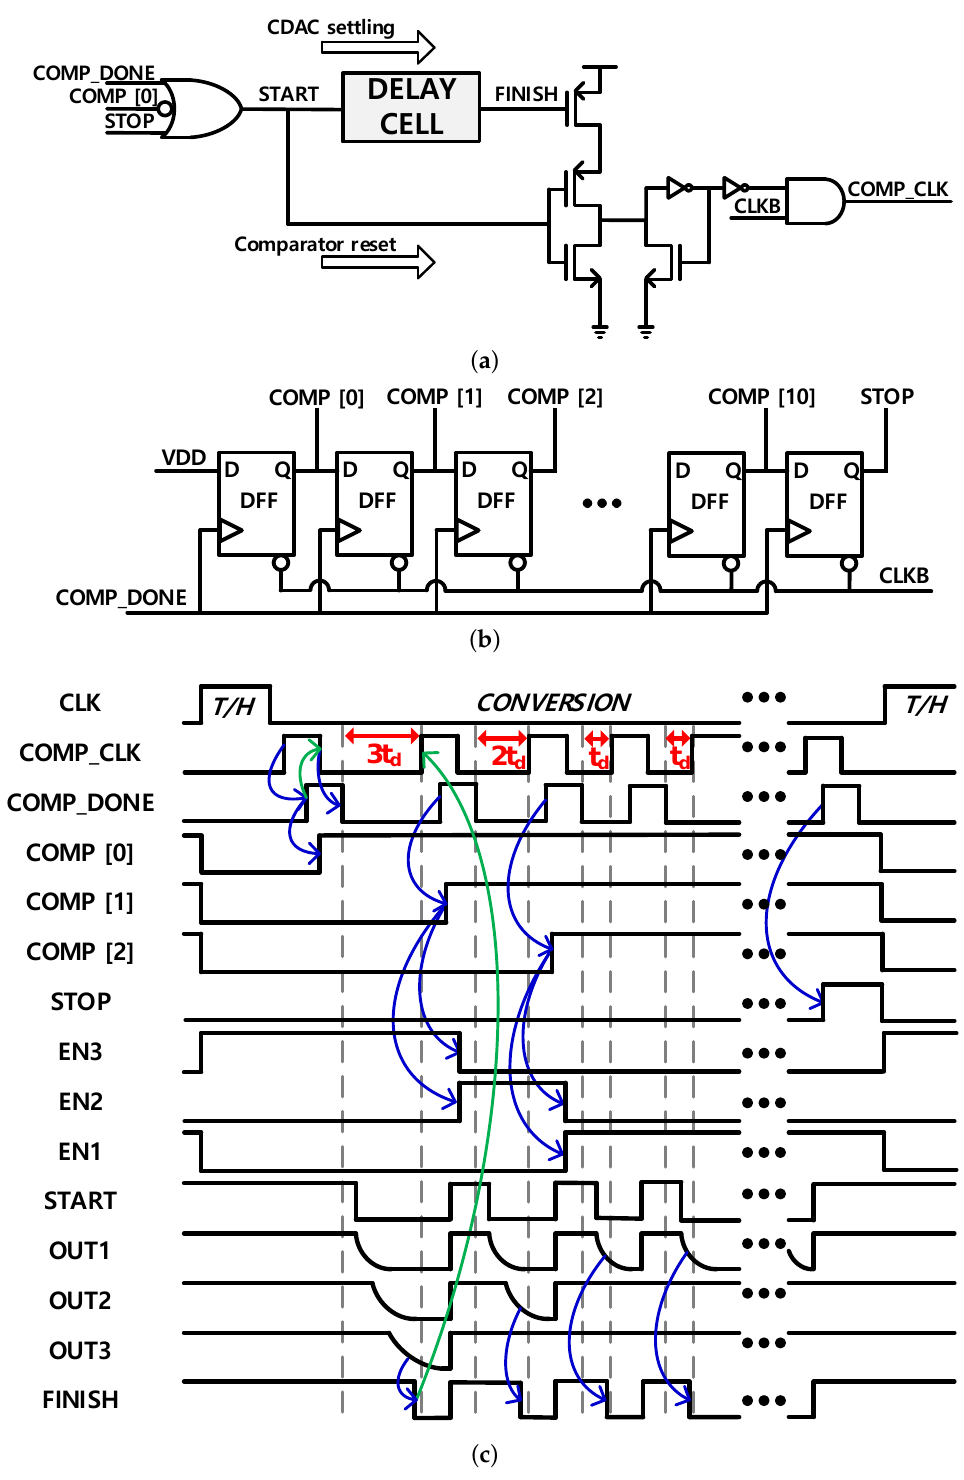
Figure 6. ( a ) Comparator clock generation circuit [16,21]. ( b ) SAR control logic [20]. ( c ) Timing diagram of comparator clock generation and control